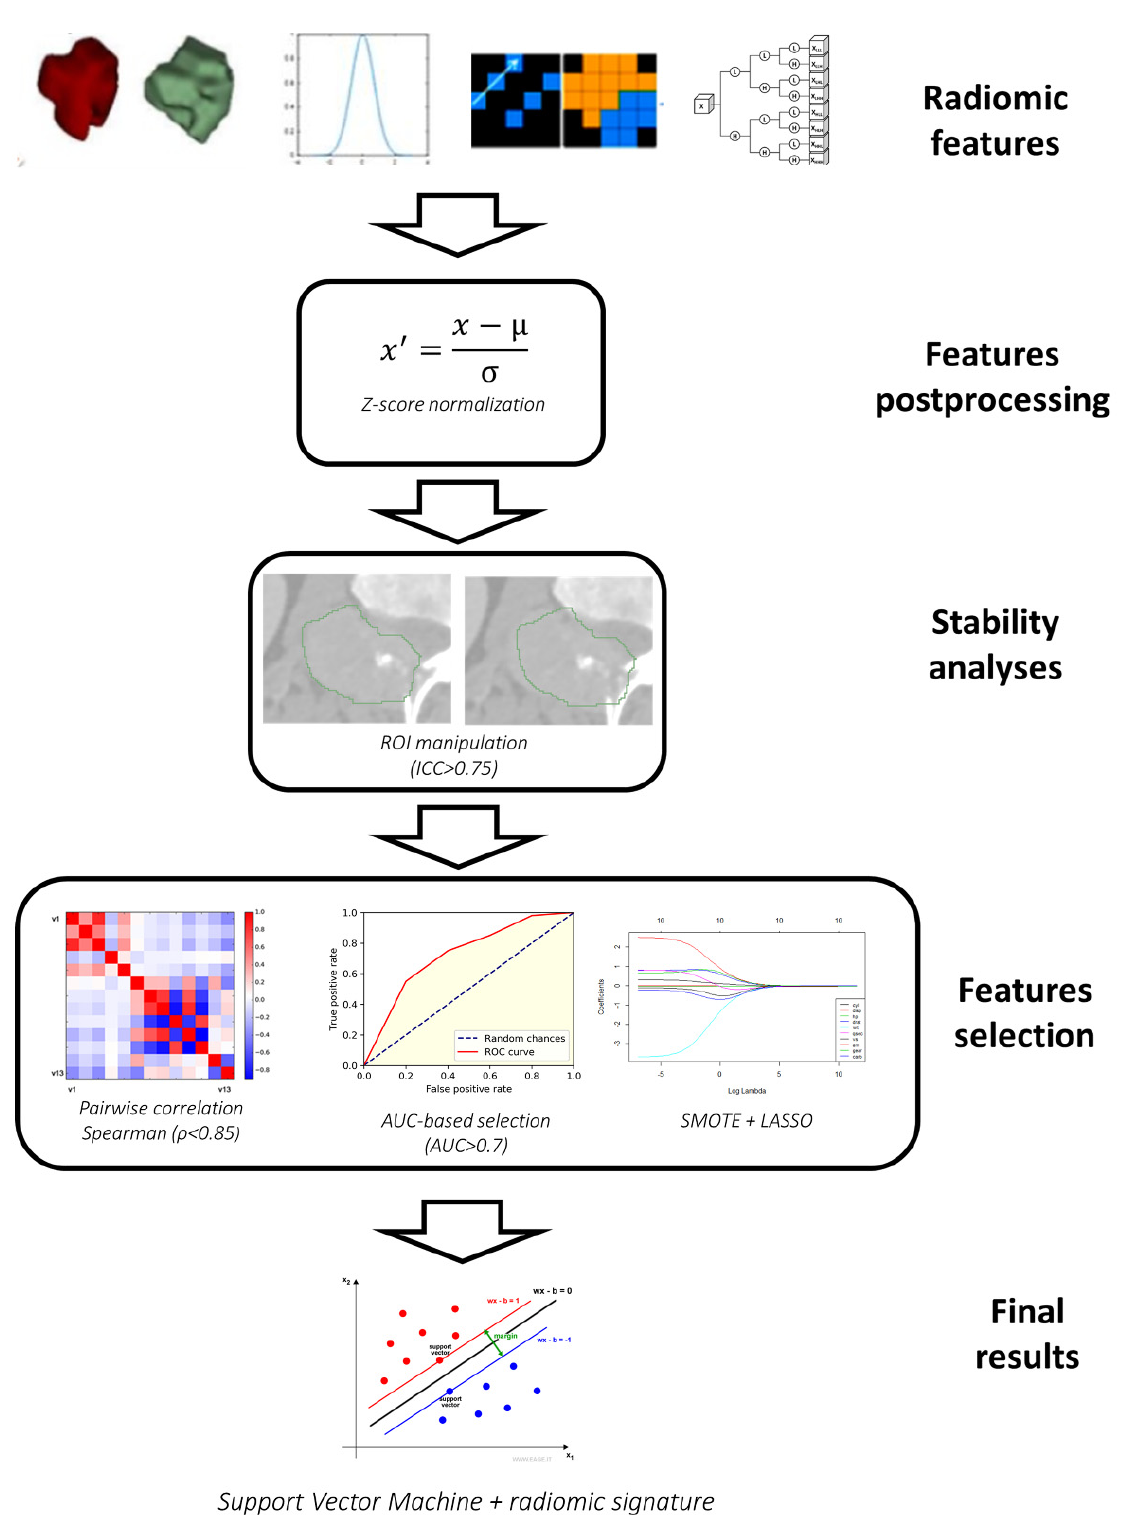
Figure 1. Workflow for the training of the radiomic signature.